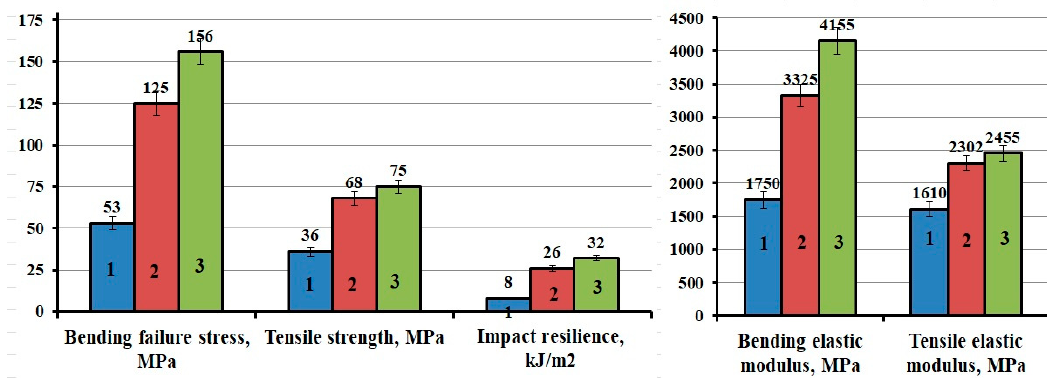
Figure 8. Physicomechanical characteristics of epoxy composites: 1-100ED-20 + 40TCEP + 15PEPA; 2-100ED-20 + 40TCEP + 0.1MWCNTs + 15PEPA; 3–100ED-20 + 40TCEP + 0.1MWCNTs (APTES) +